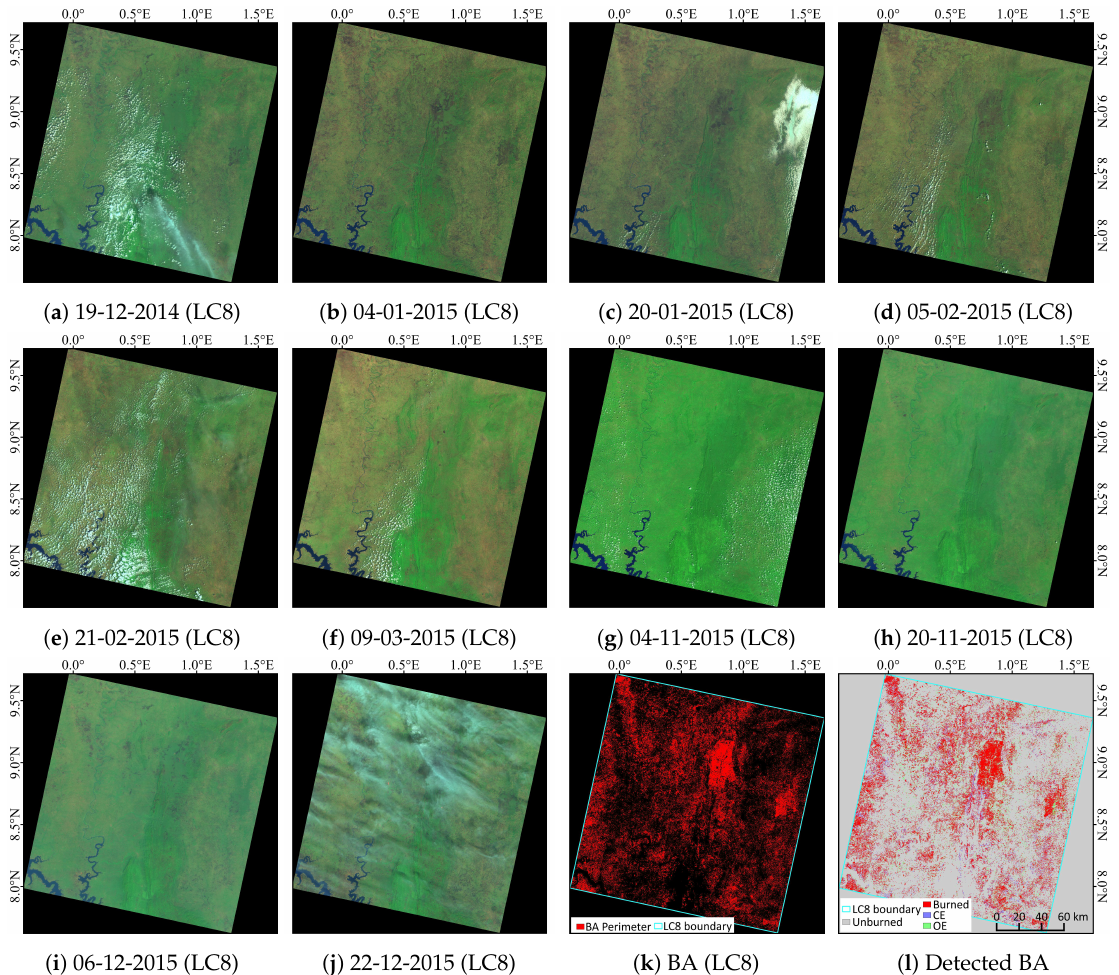
Figure A3. Example of validation using Landsat-8 images (path/row:193/054) in Africa. ( a – j ) show the Landsat-8 images used to generate the reference map, displayed in false color composition (red: SWIR2 band, green: NIR band, and blue: green band); ( k ) is the reference BA map generated from Landsat-8 images; and ( l ) is the detected BA by proposed method with CE and